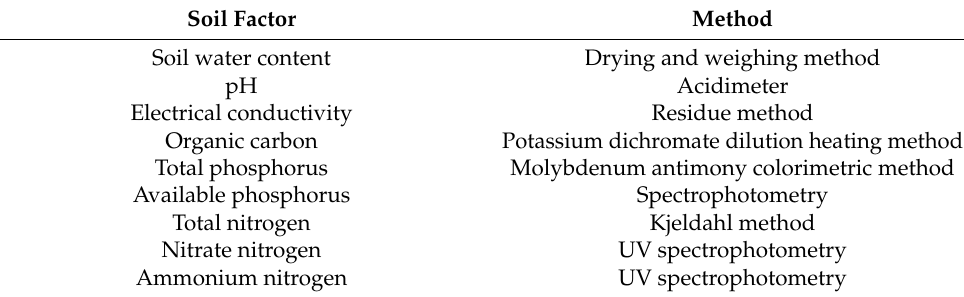
Table 1. Soil index and determination method.